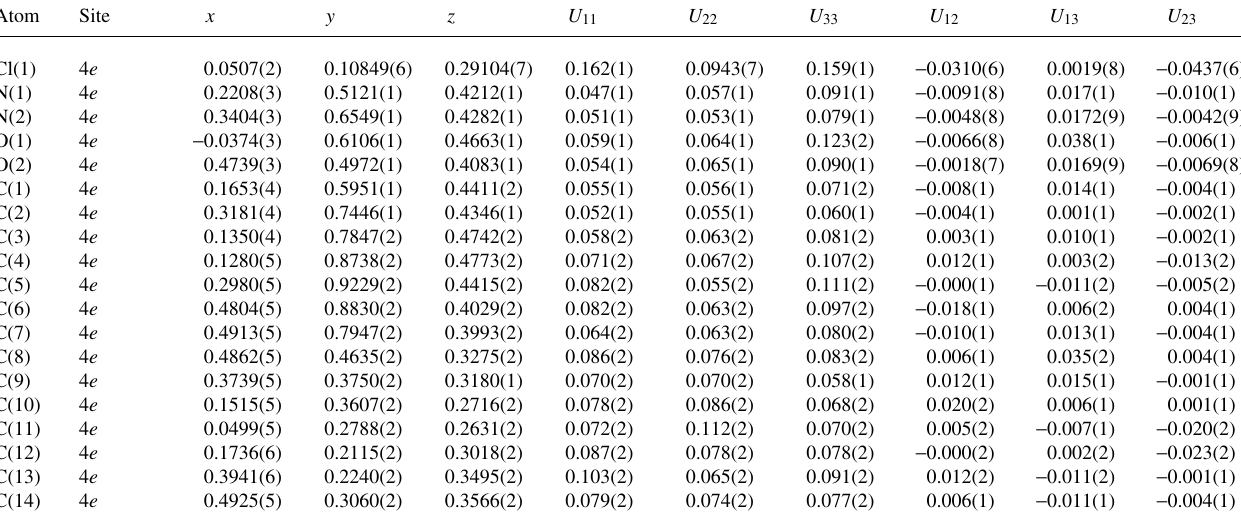
Table 3. Atomic coordinates and displacement parameters (in Å 2 )